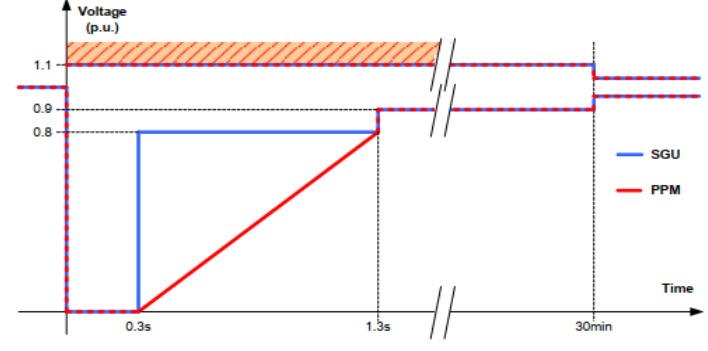
Figure 9. Typical limit curve of LVRT/HVRT requirements.